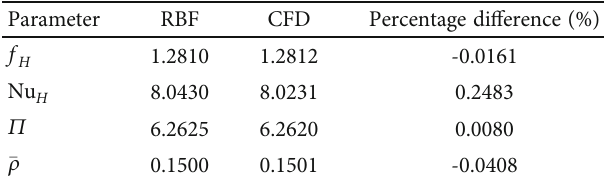
Table 6: Comparison of predicted results with CFD